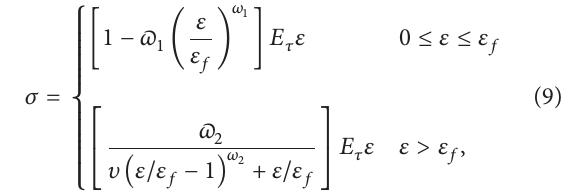
Figure 13: Comparisons of temperature rise tests’ data and conven- tional